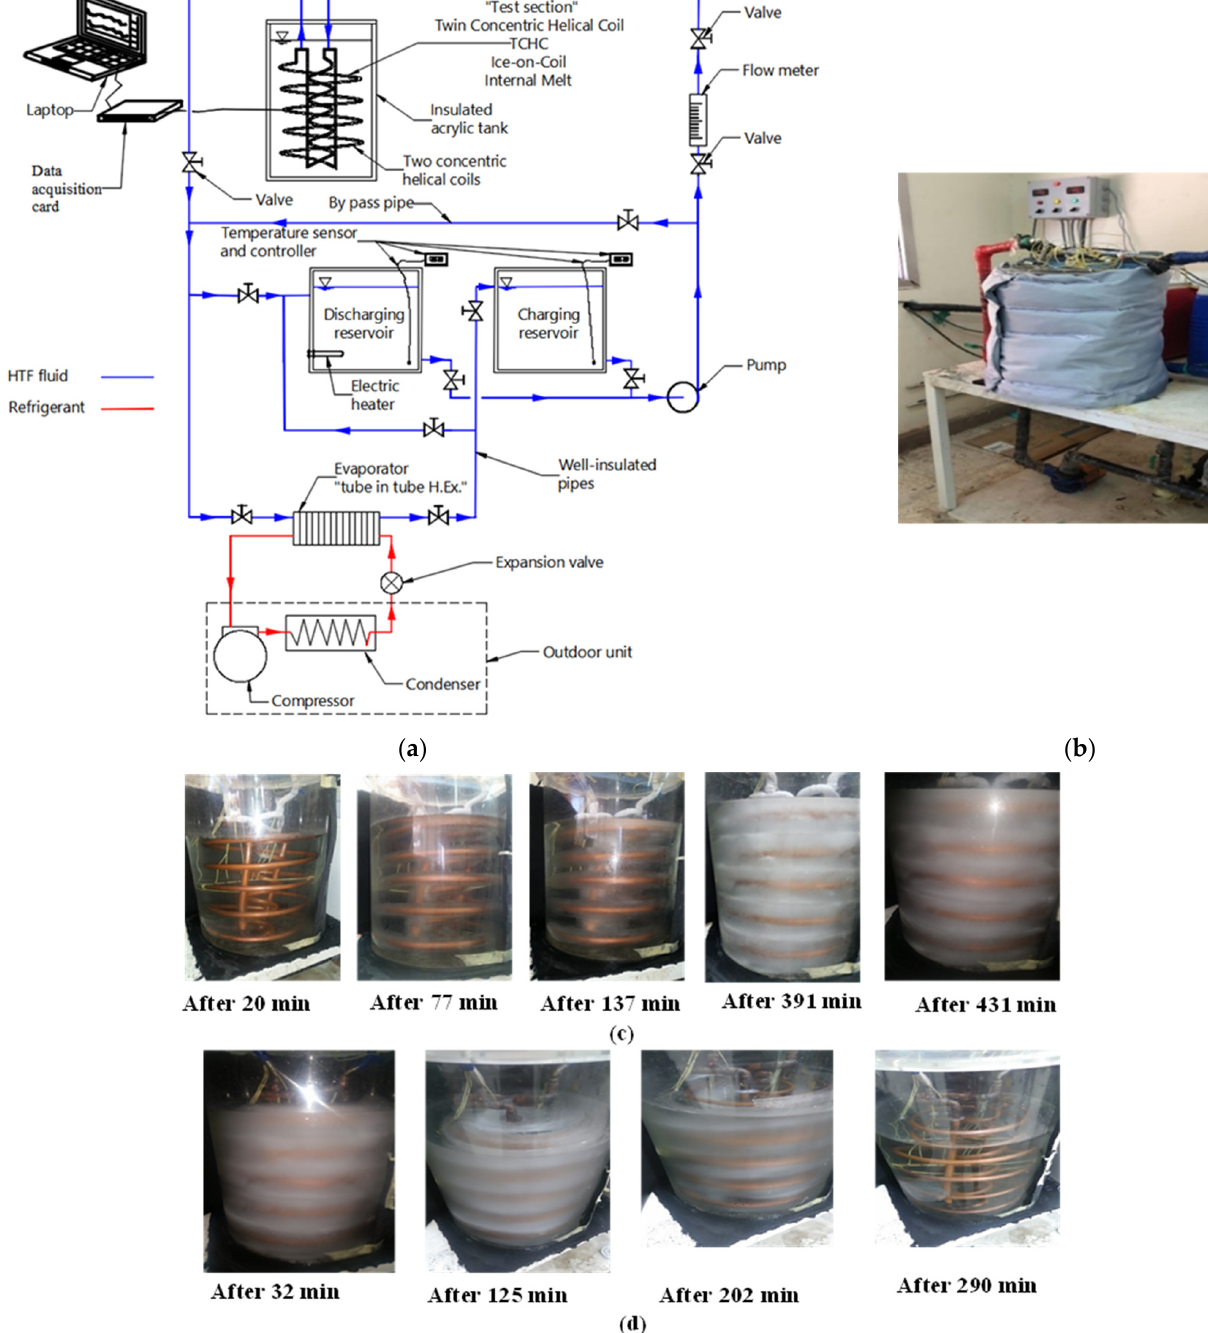
Figure 1. Experimental setup. ( a ) Schematic illustration. ( b ) Experimental test rig photo [16]. ( c ) Sample of charging experimental results. ( d ) Sample of discharging experimental results at certain time slots.